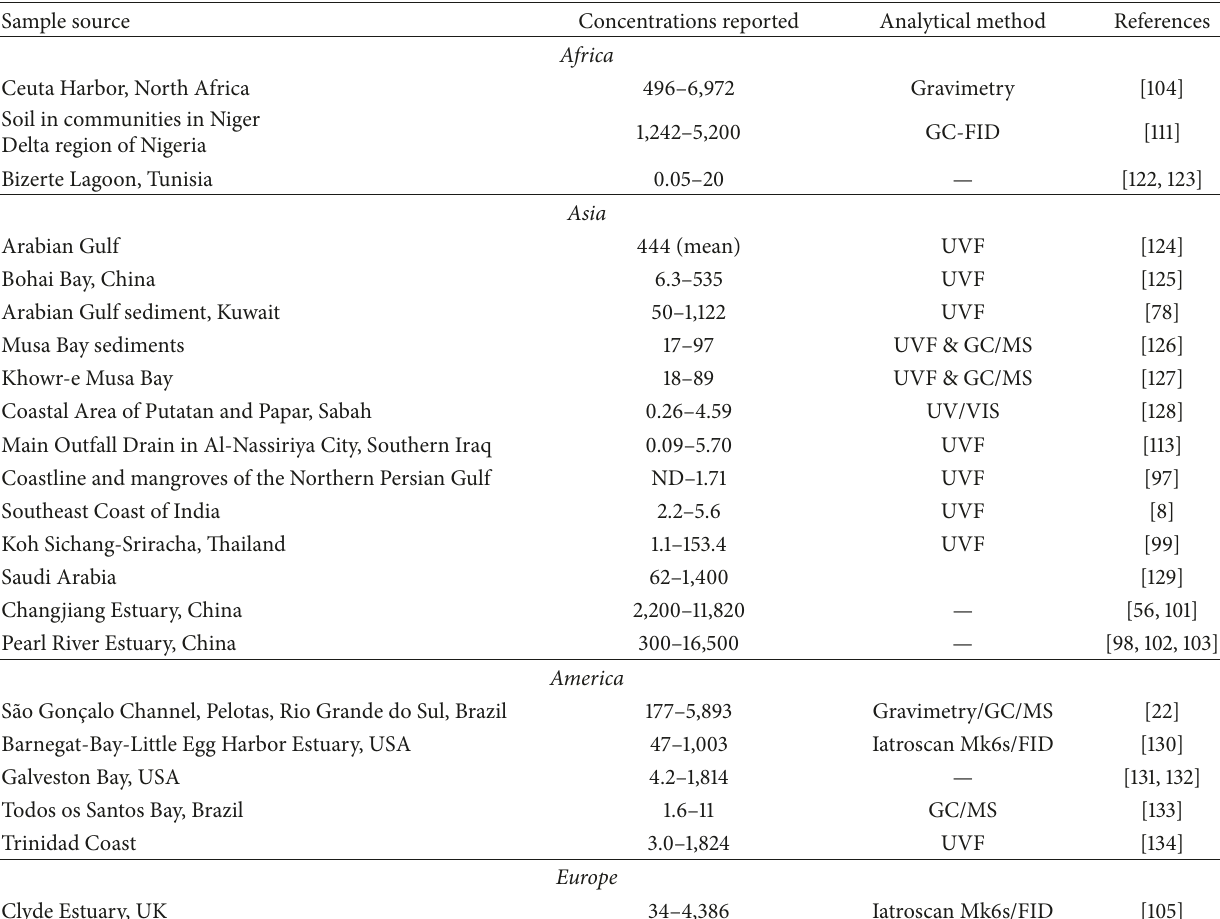
Table 2: Levels of TPHC in sediment samples around the world